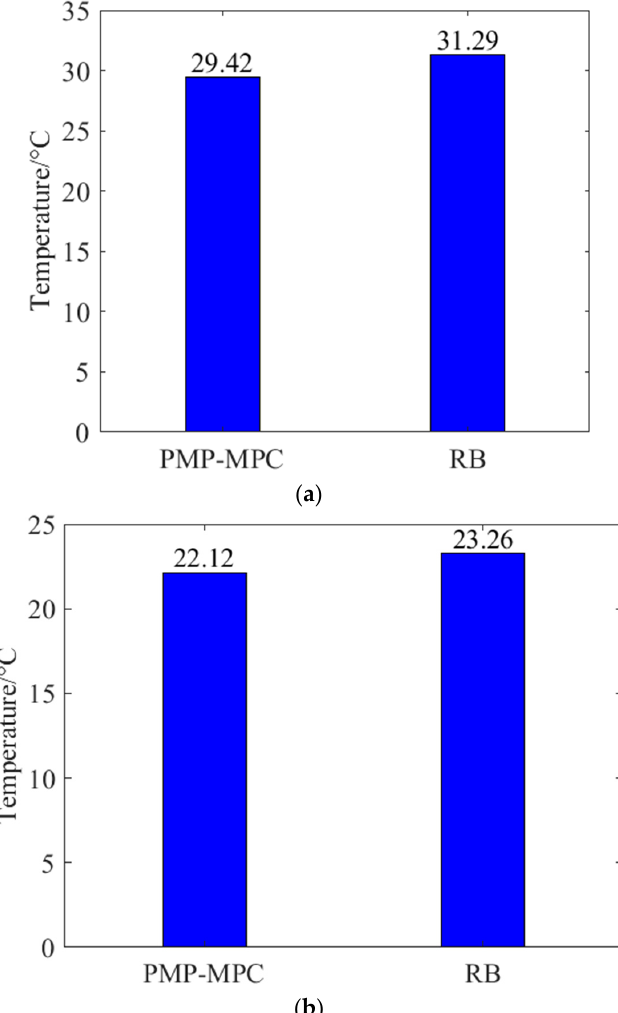
Figure 16. Battery temperatures for different methods. ( a ) Battery temperatures for different methods in driving cycle A. ( b ) Battery temperatures for different methods in driving cycle B.